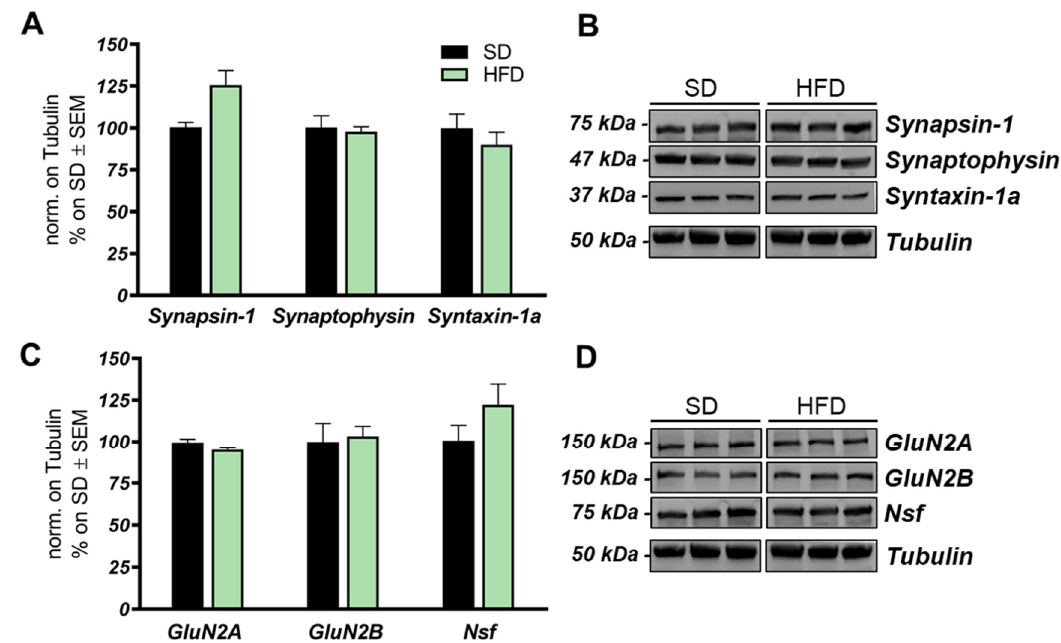
Figure 6. Expression levels of pre- and postsynaptic proteins in HFD-fed mice hippocampi. ( A , B ) Bar graph and Western blot images of synapsin-1, synaptophysin, and synthaxin-1a in the hippocampus of HFD mice compared to SD mice. ( C , D ) Bar graph and Western blot images of GluN2A and GluN2B subunits of glutamate NMDA receptor and NSF in the hippocampi of HFD mice compared to SD mice. Number of animals for Western blot analysis was 6/group. All bar charts reported in A and C show mean ± SEM. No significance was observed using Student’s t test.